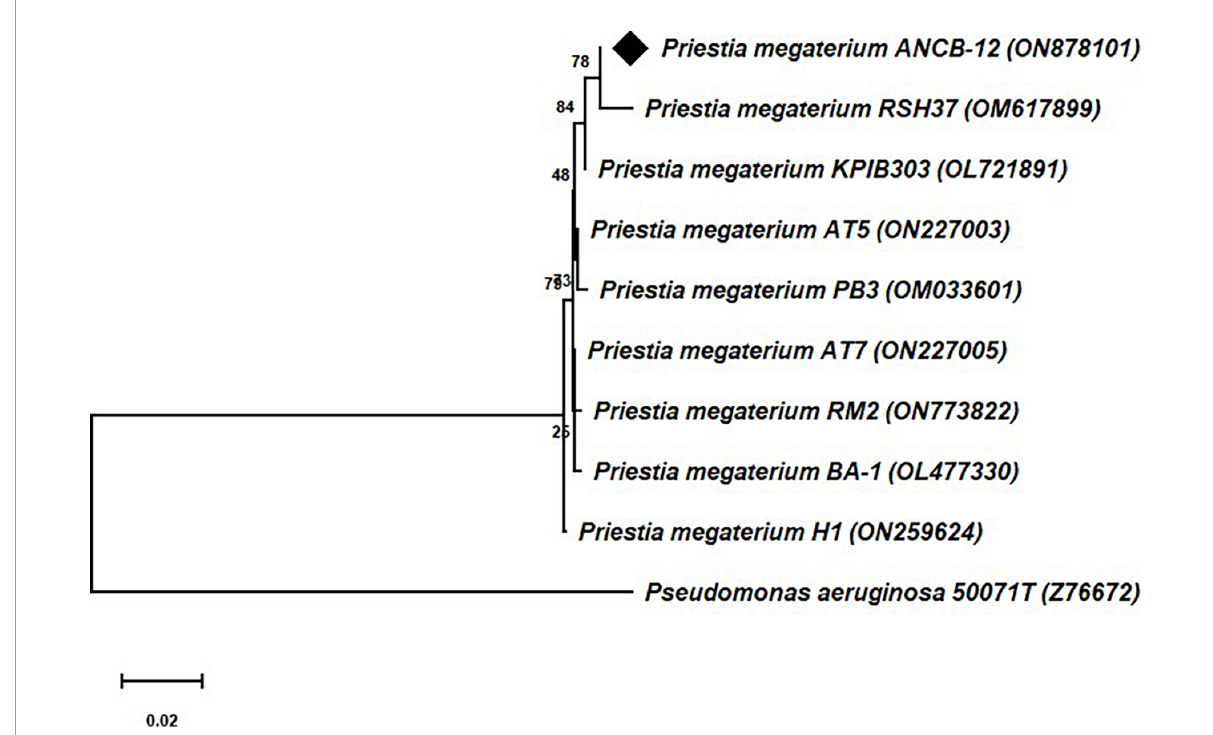
FIGURE1 Phylogenetic tree of 16S rRNA gene sequence of the isolate ANCB-12 with similar bacterial sequences of the NCBI database. The tree was constructed by using the neighbor joining method with 1,000 bootstrap re-samplings. Pseudomonas aeruginosa was taken as an out